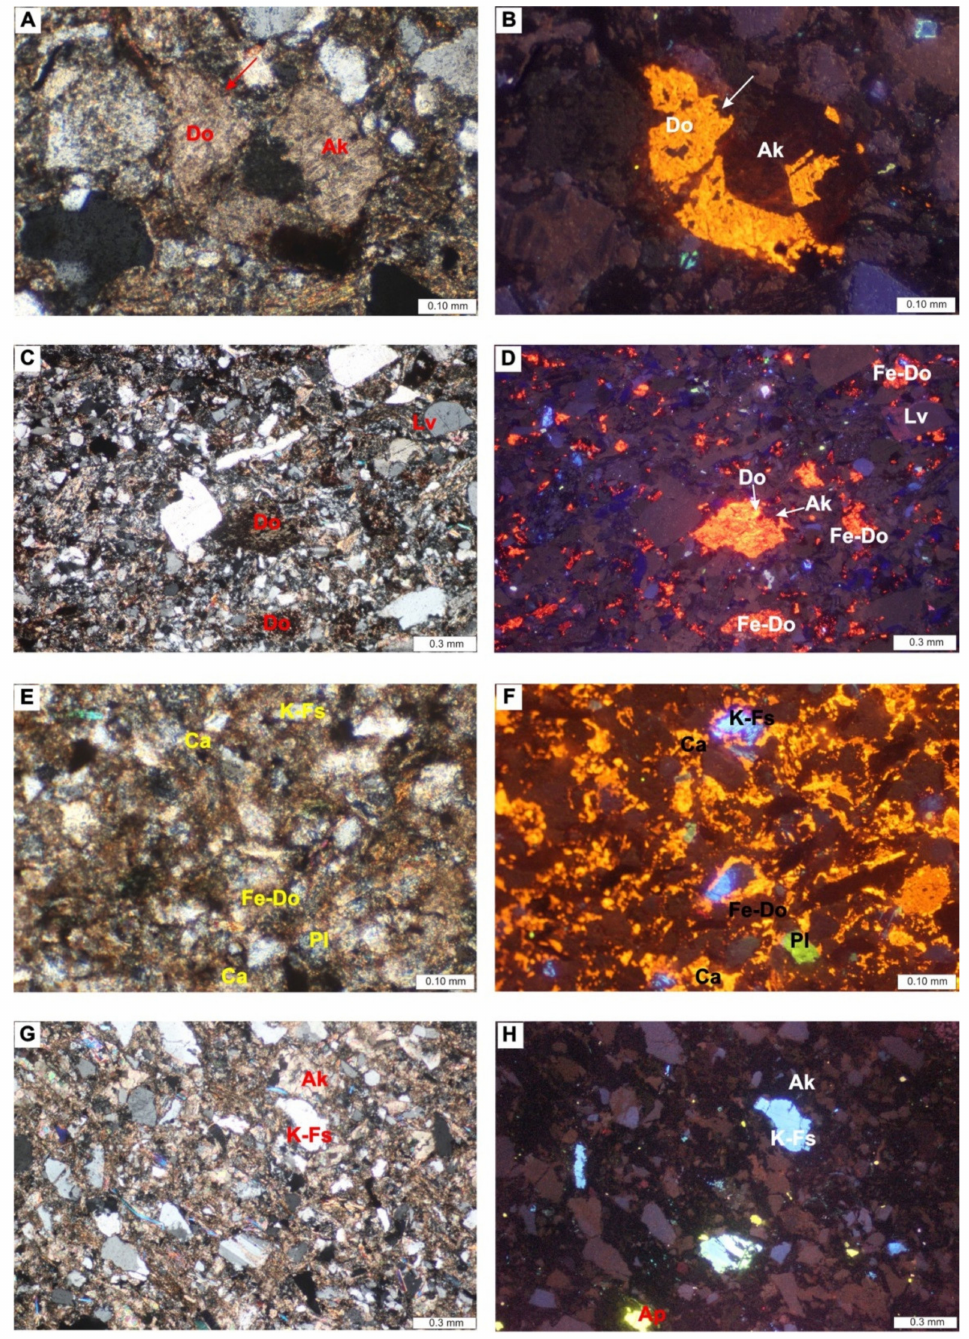
Figure 2. Photomicrographs of sandstones by a polarizing microscope (PL) and cathodoluminesence (CL). ( A ) A fragment of subarkosic wacke; dolomite (Do) and ankerite (Ak); ankerite replaces dolomite (arrow); Kalisz IG 1 borehole, depth of 3369.8 m, PL-crossed polars. ( B ) A CL image of the rock from Figure A; Dolomite (Do) displays orange luminescence, and ankerite (Ak) displays no luminescence; dolomite is replaced by ankerite (arrow). ( C ) A fragment of lithic wacke, which is a clast of acidic volcanic rock (Lv) and carbonates: dolomite (Do); Katarzynin 2, depth of 2374.1 m, PL-crossed polars. ( D ) A CL image of the rock from Figure C; the clast of acidic volcanic rock (Lv) displays brown-red luminescence, Fe-dolomite (Fe-Do) luminesce is red, dolomite (Do) is yellow, and ankerite (Ak) displays no luminescence. ( E ) A fragment of subarkosic arenite-potassium feldspar (K-Fs), plagioclase (Pl) and carbonate: calcite (Ca), Fe-dolomite (Fe-Do); Objezierze IG 1 borehole, depth of 5082.0 m, PL-crossed polars. ( F ) A CL image of the rock from Figure E; potassium